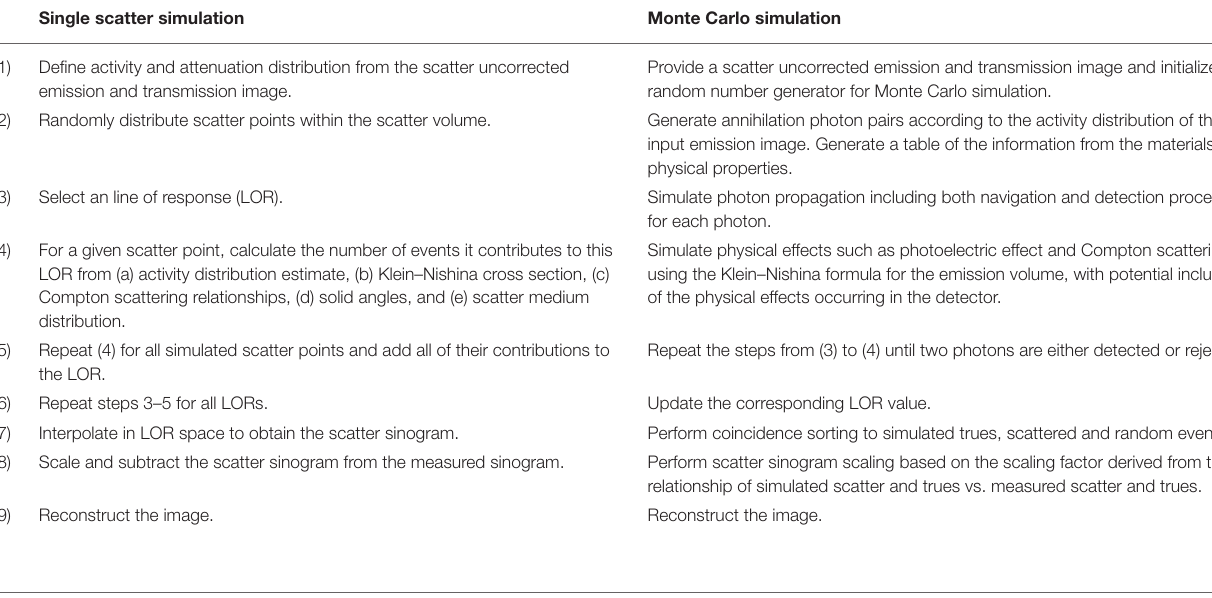
TABLE 2 | Flowchart of single scatter simulation following the methodology in Accorsi et al. [145], Watson et al. [146], and Ollinger [147] in comparison to Monte Carlo simulation-based scatter correction shown in Kim et al. [148], Magota et al. [149], and Ma et al. [150]. Single scatter simulation Monte Carlo